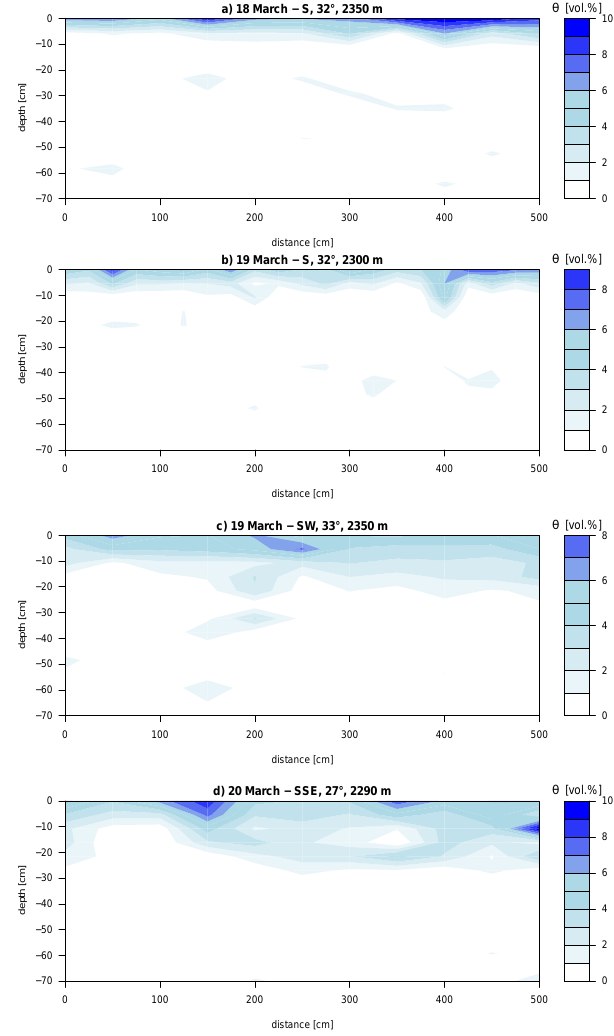
Fig. 10. State of snow wetness, 18 - 20 March 2010 on southerly Fig. 11. State of snow wetness, 18–20 March 2010 in the beginning aspect slopes at similar altitudes in the beginning of the melt phase. of the melt phase. Contour plots showing cross-sections of snow Contour plots showing cross-sections of snow wetness ( θ ) to a depth wetness ( θ ) to a depth of up to 70cm over 5m wide areas across the of up to 70 cm over 5 m wide areas across the slope. All observa- slope. All observations were observed in shallow snowpack areas at tions were observed in shallow snowpack areas at similar elevations similar elevations (2000–2300m) in southerly aspect slopes (SE, S, (2000 - 2300 m) in southerly aspect slopes (SE, S, SW). θ , measured SW). θ , measured with the Snow Fork, is corrected by − 0.8vol.% with the Snow Fork, is corrected by -0.8 vol.% (this corresponds to (this corresponds to the median offset in dry snow). θ -values greater the median offset in dry snow). θ -values greater than 10 vol.% are than 10vol.% are shown as shown as 10 vol.%.